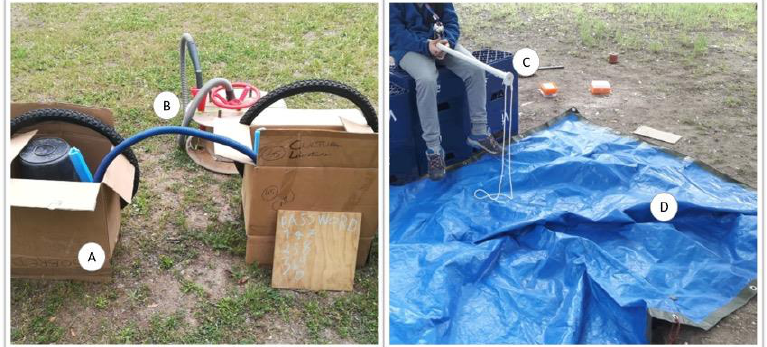
Figure 1. A. Cardboard boxes: flexible, changeable, lightweight, easily tearable; B. Plastic tubes: thin, long, flexible, unchangeable structure but changeable shape, lightweight; C. Plastic crates: rigid, heavy, unchangeable structure, stackable; D. Tarpaulin and fabrics: flexible, unchangeable structure but changeable shape, lightweight, and can occupy a large area.